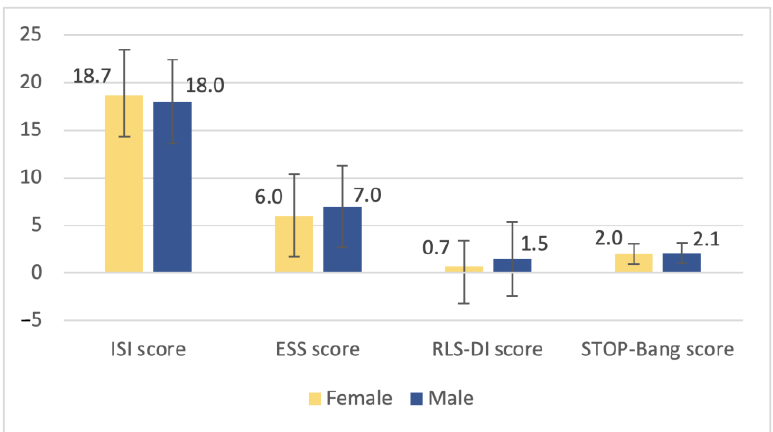
Figure 1. Results of the sleep-related patient questionnaires in points. ISI = Insomnia Severity Index, ESS = Epworth Sleepiness Scale, RLS-DI = Restless Legs Syndrome-Diagnostic Index.